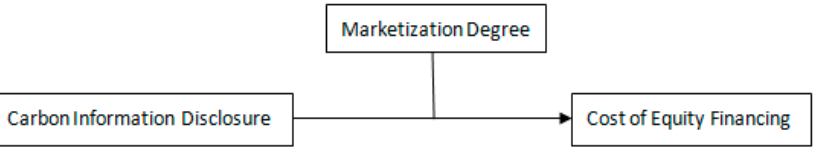
Figure 2. The moderating effect of marketization degree.